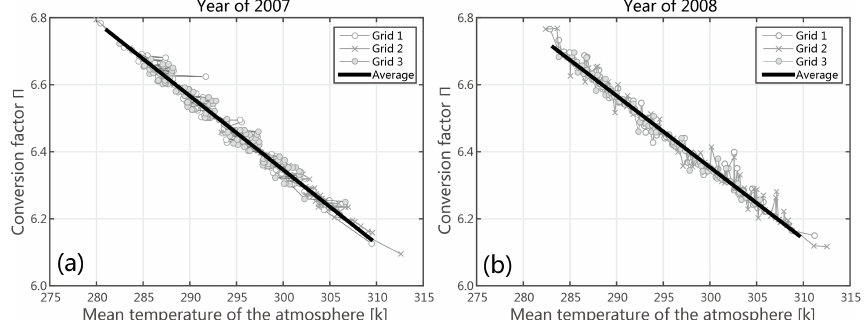
Figure 3. Conversion factor (cid:53) estimated based on the water vapour partial pressure and temperature extracted at three ERA-Interim model grids located within the SAR scene (see Fig. 1). The black line is the linear regression between the averaged conversion factors and the mean temperature. The measurements were taken at 18:00UTC (close to the SAR acquisition time of 18:01UTC, making the time difference between these two data sets negligible) over 120 days (10 days/month) in the years 2007 (a) and 2008 (b)